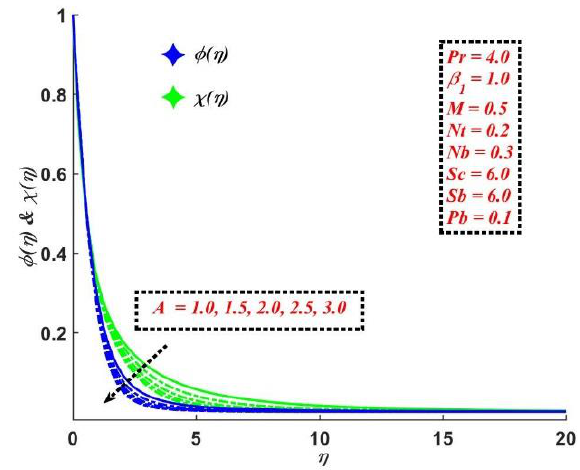
Figure 2. Influence of the curvature parameter on 𝐹 ′ (𝜂) and 𝜃(𝜂) .